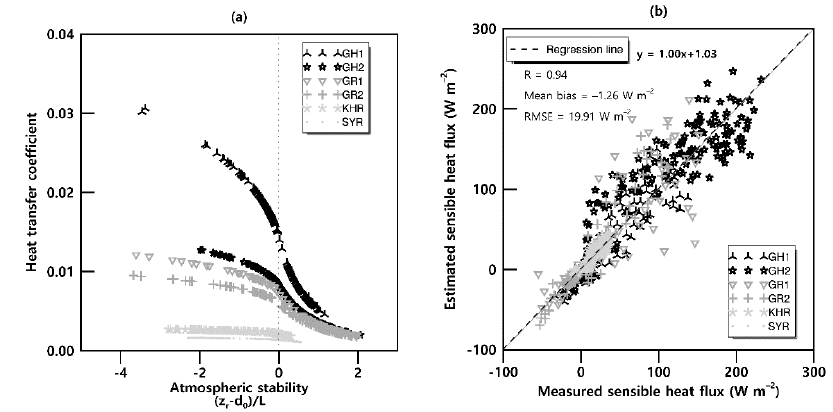
Figure 2. ( a ) Heat transfer coefficients as functions of atmospheric stability ((z r -d 0 )/L) for different surfaces and ( b ) comparison of sensible heat fluxes estimated by the bulk transfer method with the sensible heat flux measured by 3D ultrasonic anemometer and SLS20 at sites KHR and